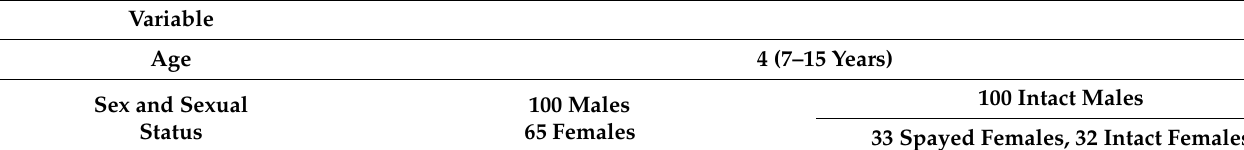
Table 2. Descriptive statistics of included dogs with population sample characterization and blood